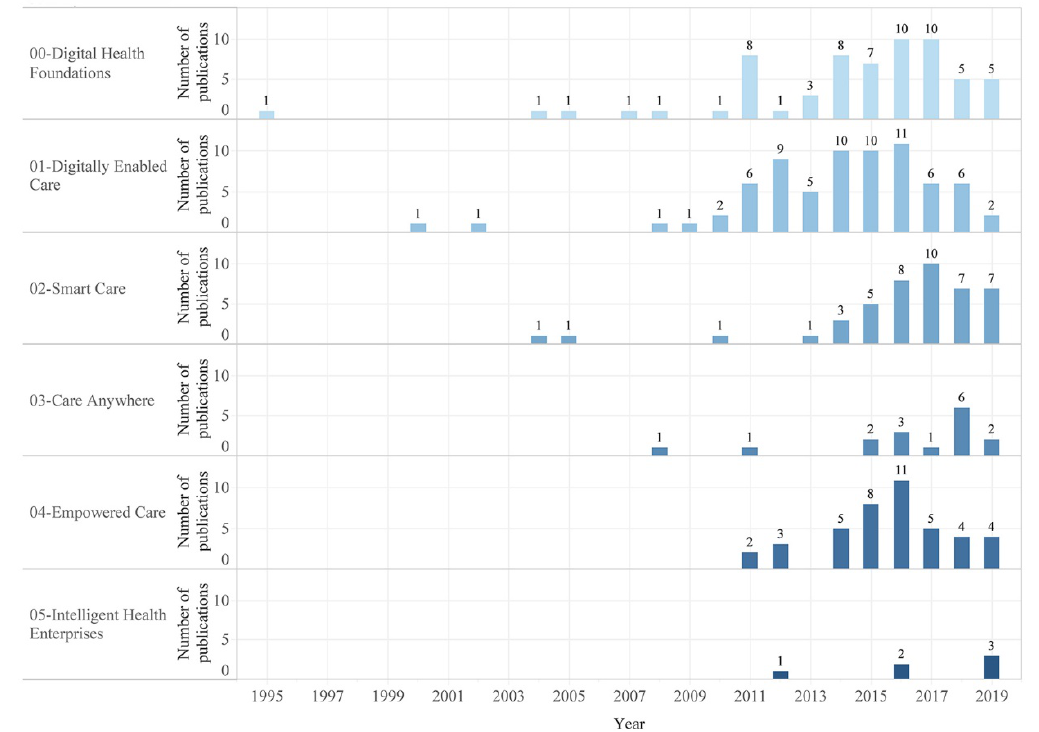
Figure 4 Trends in publications categorized based on the Ministry of Health’s (MOH’s) “digital health journey” framework over